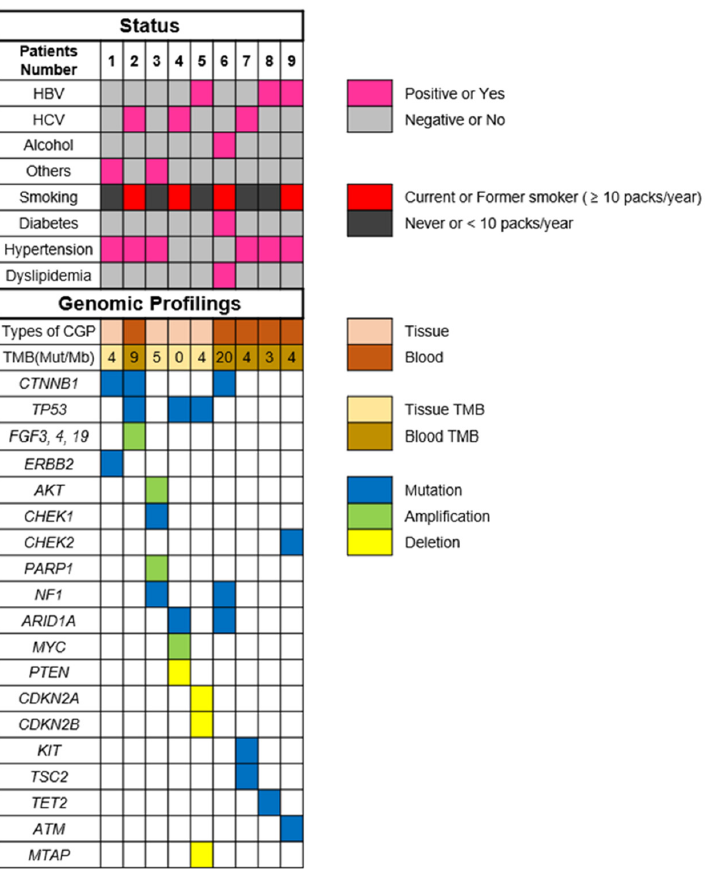
Figure 2. Results of comprehensive genomic profiling in patients with unresectable hepatocellular carcinoma. Abbreviations: TMB—tumor mutation burden; HBV—hepatitis B virus; HCV—hepatitis C virus; and others mean non-HBV, non-HCV, and non-alcohol.